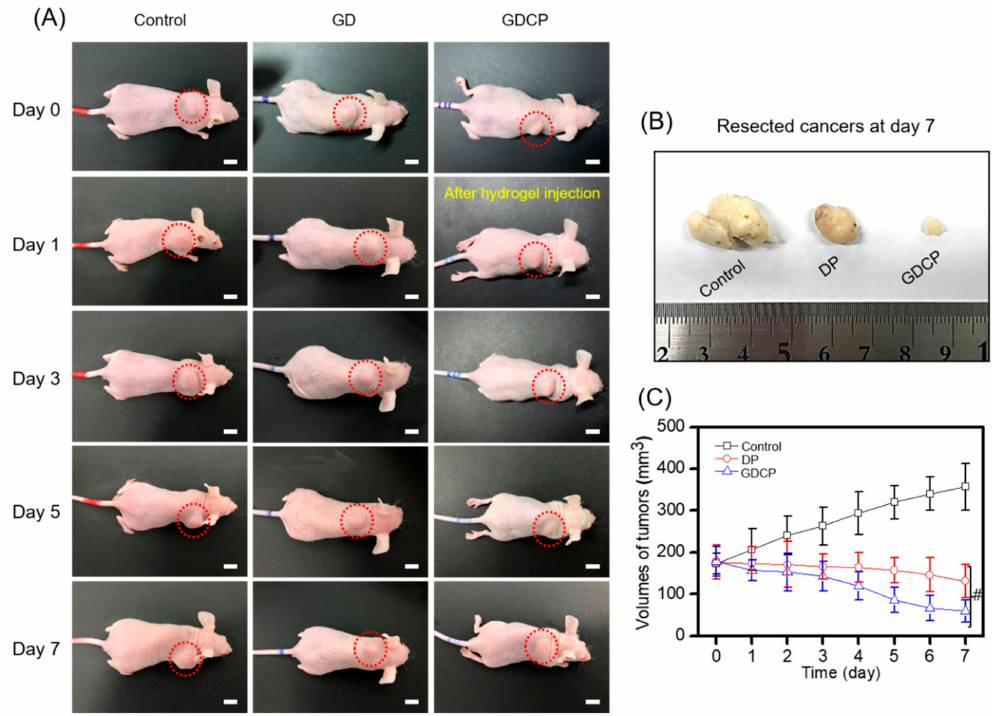
Figure 4. ( A ) Gross appearances of cancers bearing to the backs of control and DOX · HCl / PTX- and GDCP-treated mice observed before intravenous injection, and at Day 1, 3, 5, and 7 after the injection. ( B ) Cancer resected from control and DOX · HCl / PTX- and GDCP-treated mice at Day 7. ( C ) Volumes of tumors in control and DOX · HCl / PTX- and GDCP-treated mice ( # p < 0.05). These values were expressed as the mean ± standard deviation. Scale bar indicates 1